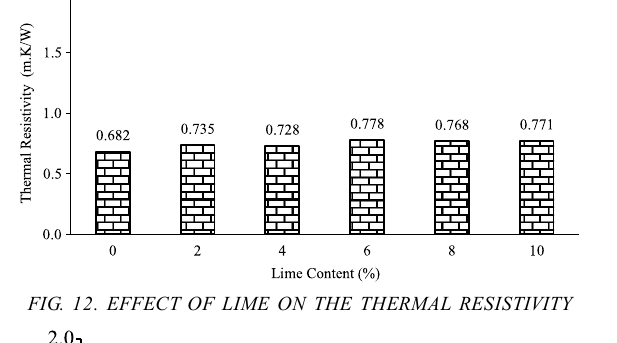
FIG. 12. EFFECT OF LIME ON THE THERMAL RESISTIVITY